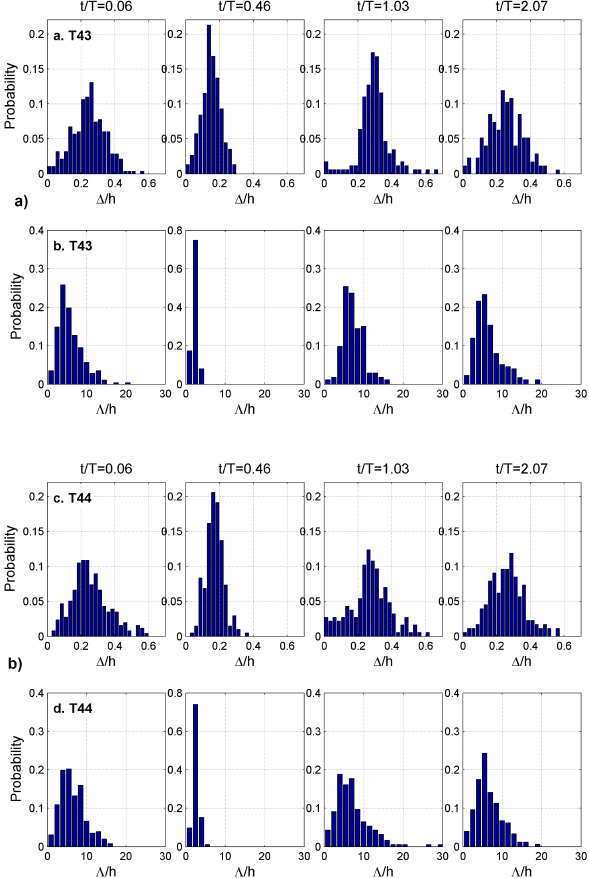
Figure 5. Probability distributions of normalized dune heights (a, c) and lengths (b, d) for the fast and slow discharge waves at three times during the steep flood wave (start: t /T wave =0.06, peak: t /T =0.46, and end: t /T wave =1.03) and at the end of the experi- ment ( t /T wave =2.07). Number of individual dunes between ≈ 280 ( t /T wave =0.46) and ≈ 170 ( t /T wave